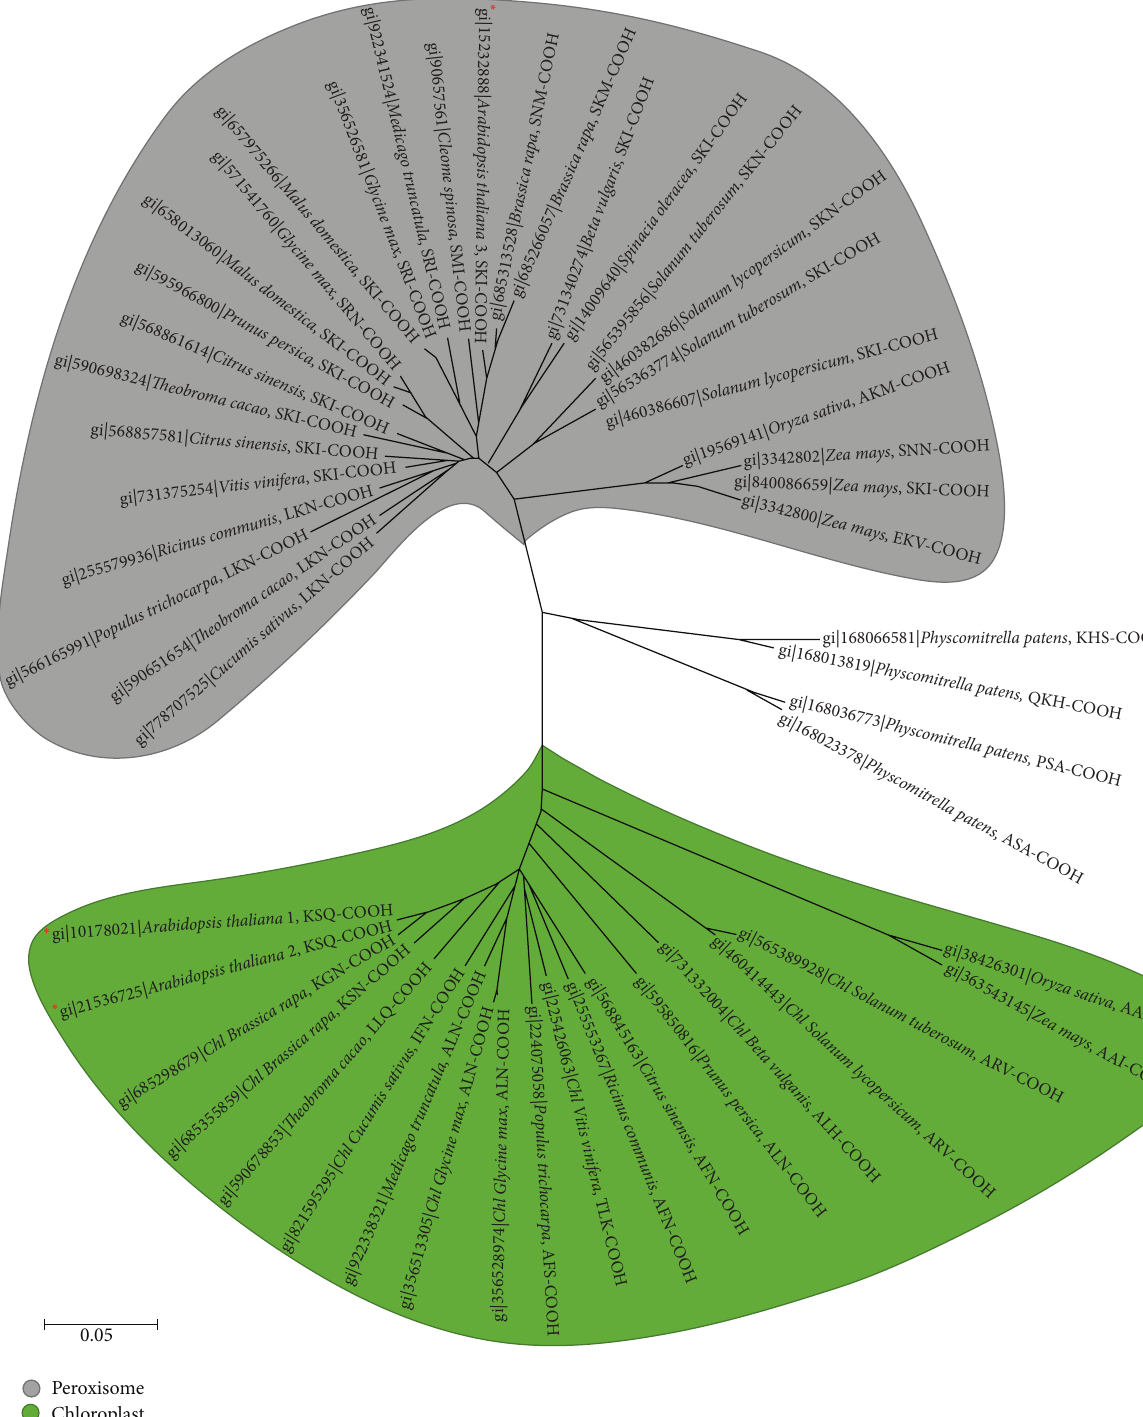
Figure 2: Evolutionary relationships of plant 6PGDHs. The evolutionary history was inferred using the Neighbor-Joining method. The optimal tree with the sum of branch length = 2,42428701 is shown. The tree is drawn to scale, with branch lengths in the same units as those of theevolutionary distances usedtoinfer thephylogenetic tree. Theevolutionary distances werecomputed usingthePoissoncorrection method and are in the units of the number of amino acid substitutions per site. The rate variation among sites was modeled with a gamma distribution (shape parameter = 1). The analysis involved 51 amino acid sequences. All positions containing gaps and missing data were eliminated. There were a total of 416 positions in the final dataset. Evolutionary analyses were conducted in MEGA6